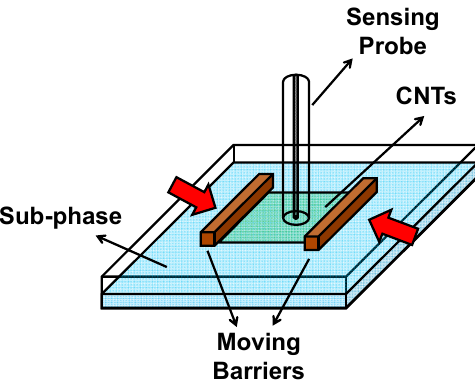
Figure 3. Schematic of the Langmuir-Blodgett deposition process.